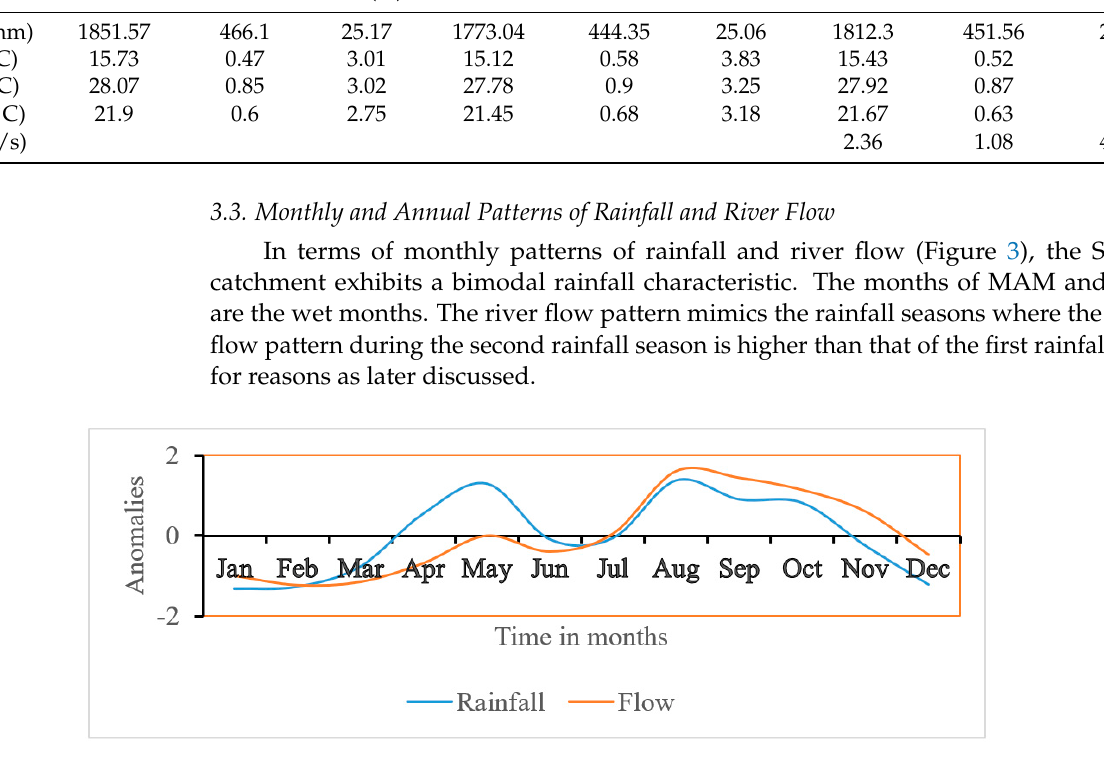
Figure 4. Annual patterns of rainfall in Buginyanya and Kapchorwa and River Sioi flow (1998–2015).